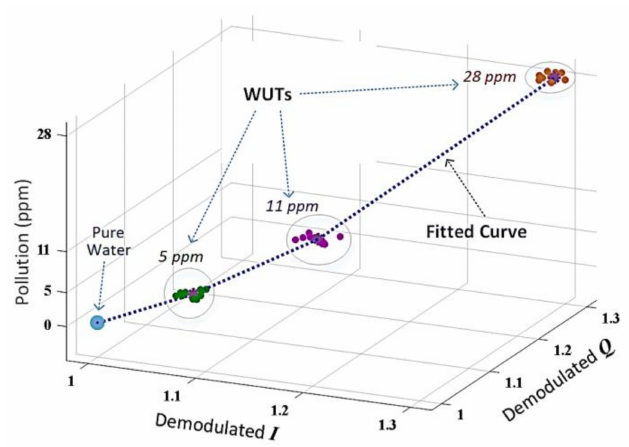
Figure 7. Demodulated data at the receiver (I: real part, Q: imaginary